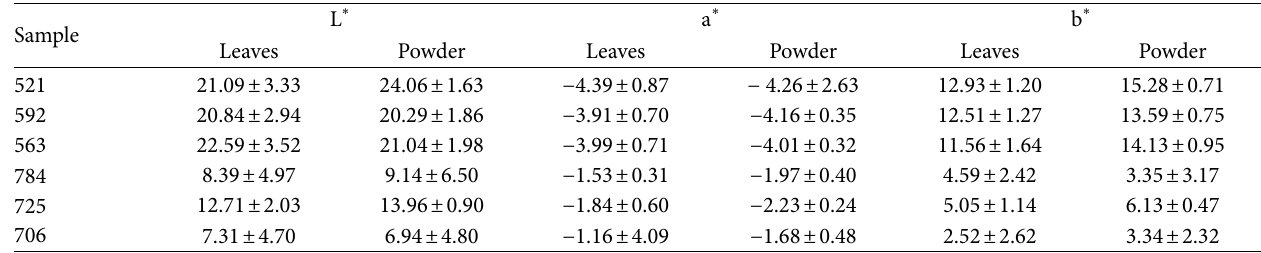
Table 4: The L values of the dried leaves and